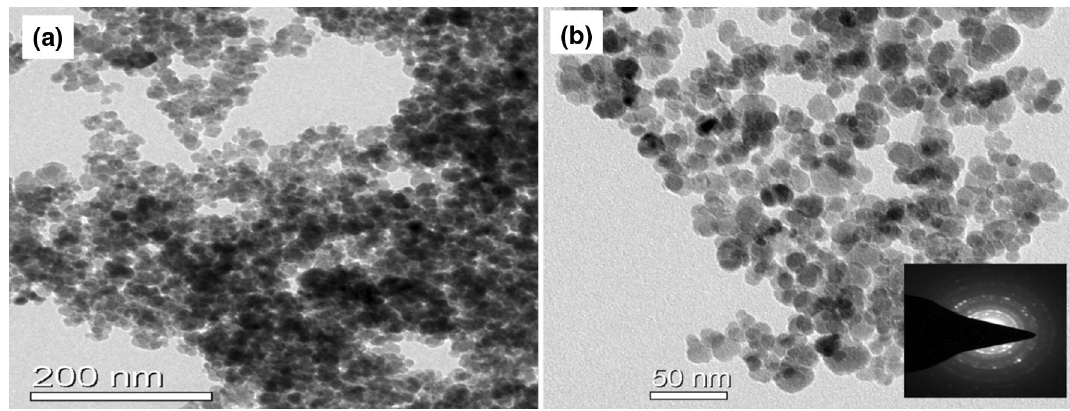
3 O 4 NPs at different magnification scale (inset selected area electron diffraction